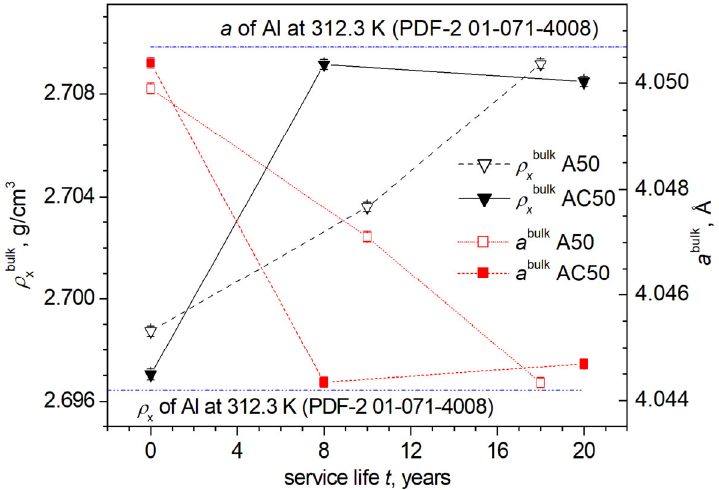
Figure 23. Dependences of the densities ρ x bulk and unit cell parameters a bulk in the bulk of the wires from the cables of AAAC (A50) and ACSR (AC50) types on the service life t of the cables.